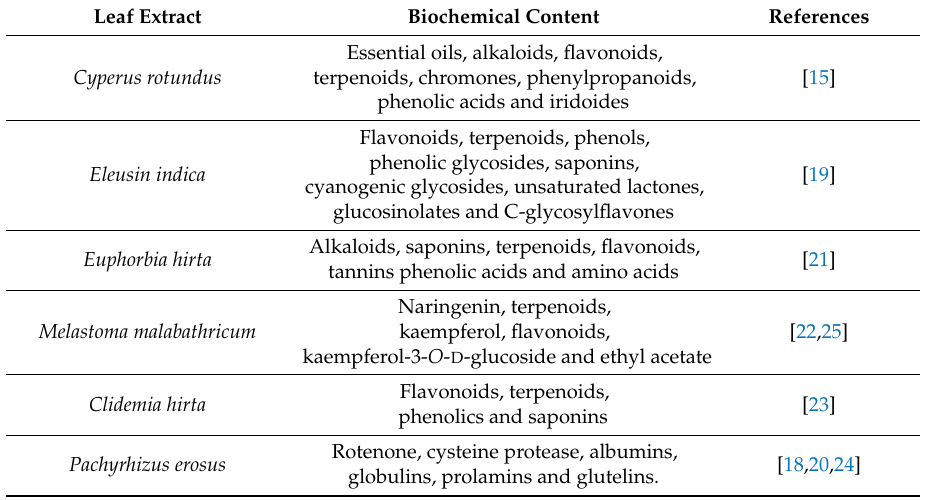
Table 1. Biochemical contents of all employed plants.